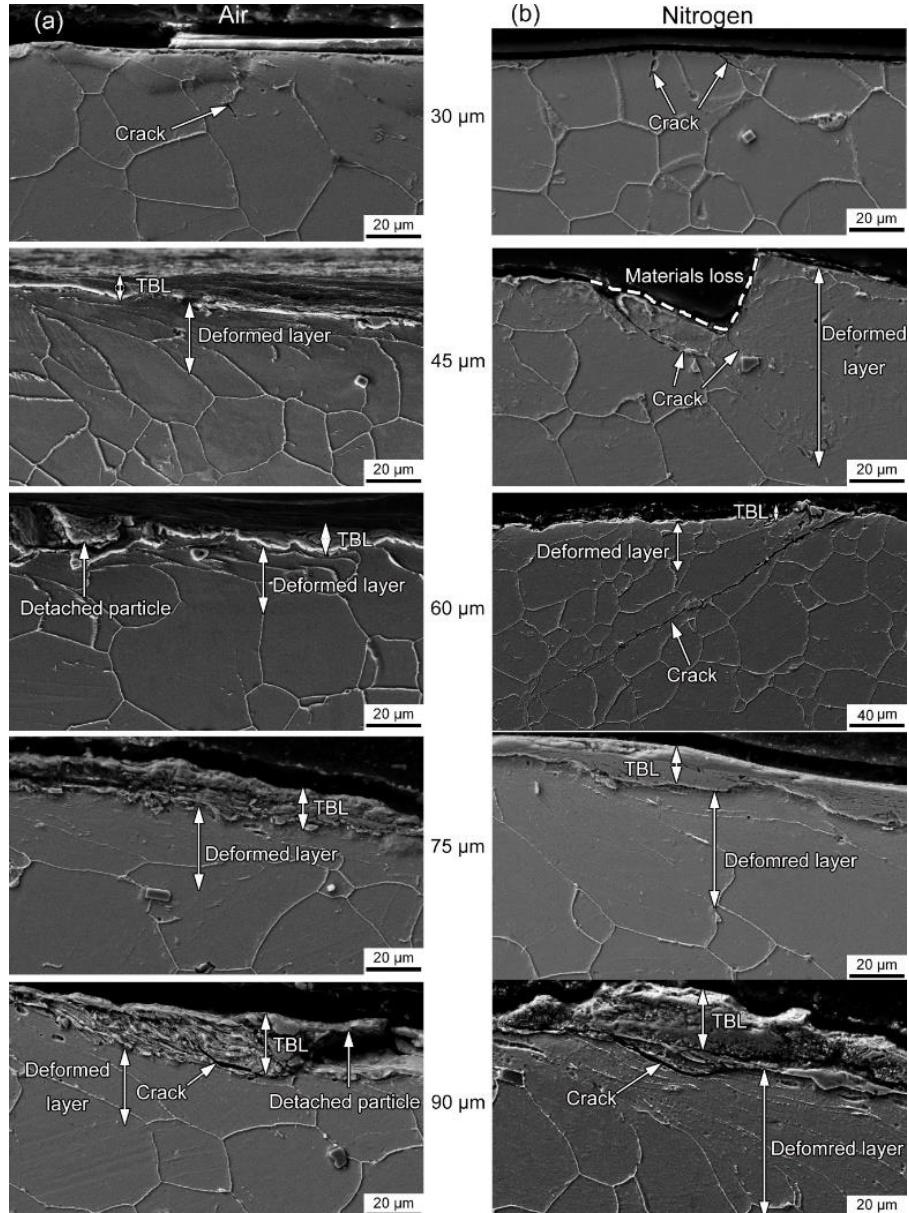
Figure 7. The SEM images of wear sub-surfaces in alloy 690 during fretting wear at different displacement amplitudes in ( a ) air and ( b ) nitrogen.